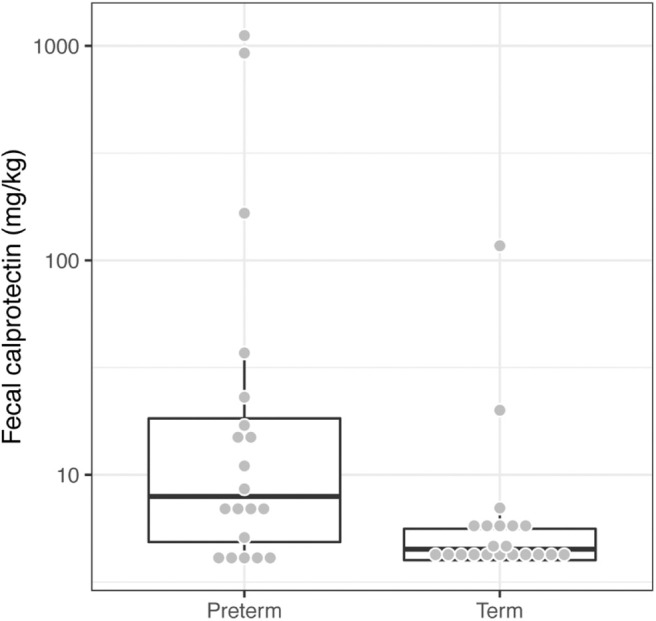
Children born very preterm had higher fecal calprotectin levels compared to term children (Wilcoxon test, p = 0.0064). The fecal calprotectin concentrations, y-axis, are shown on a logarithmic scale.